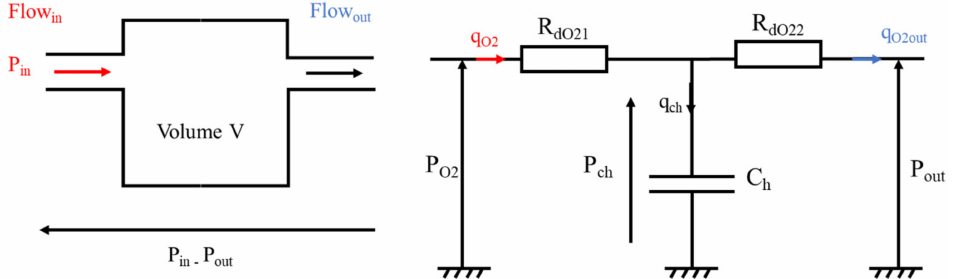
Figure 5. Analogy between pipe of the hydraulic circuit and an electric RC circuit. The oxygen circulation qO2 is enabled by fuel cell input/output pressure difference. The consumed (resp. produced) gases’ flows qcO2 are calculated from the Faraday law and the number of electrons exchanged nO2 counted negatively (resp. positively). Partial pressures at each electrode are imposed by the gas accumulation represented by qch. Ifc is the electric current of the fuel cell, N is the number of cells.